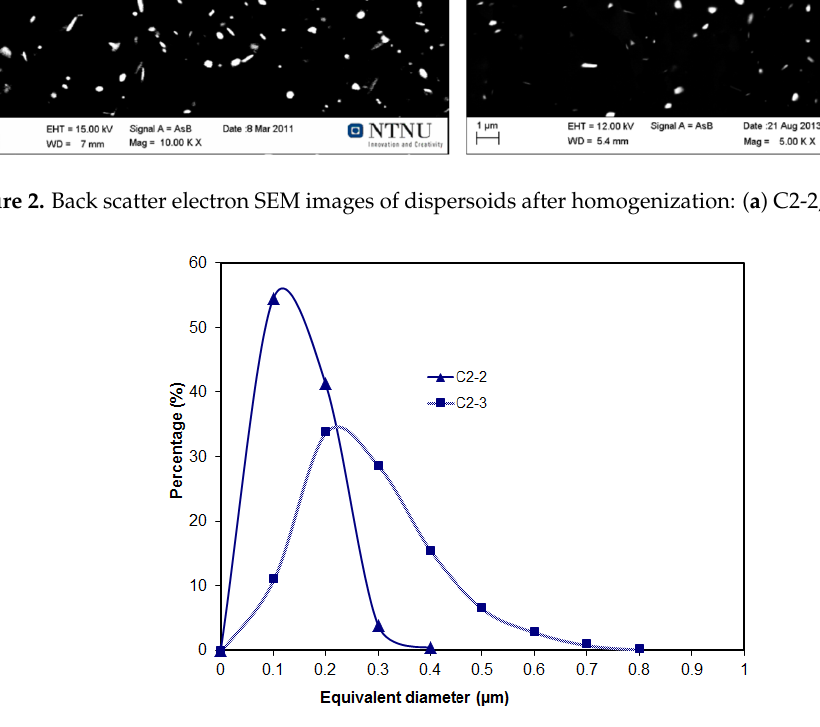
Figure 3. Distribution of mean diameter of precipitated particles after homogenization in the C2 ‐ 2 and C2 ‐ 3 materials.